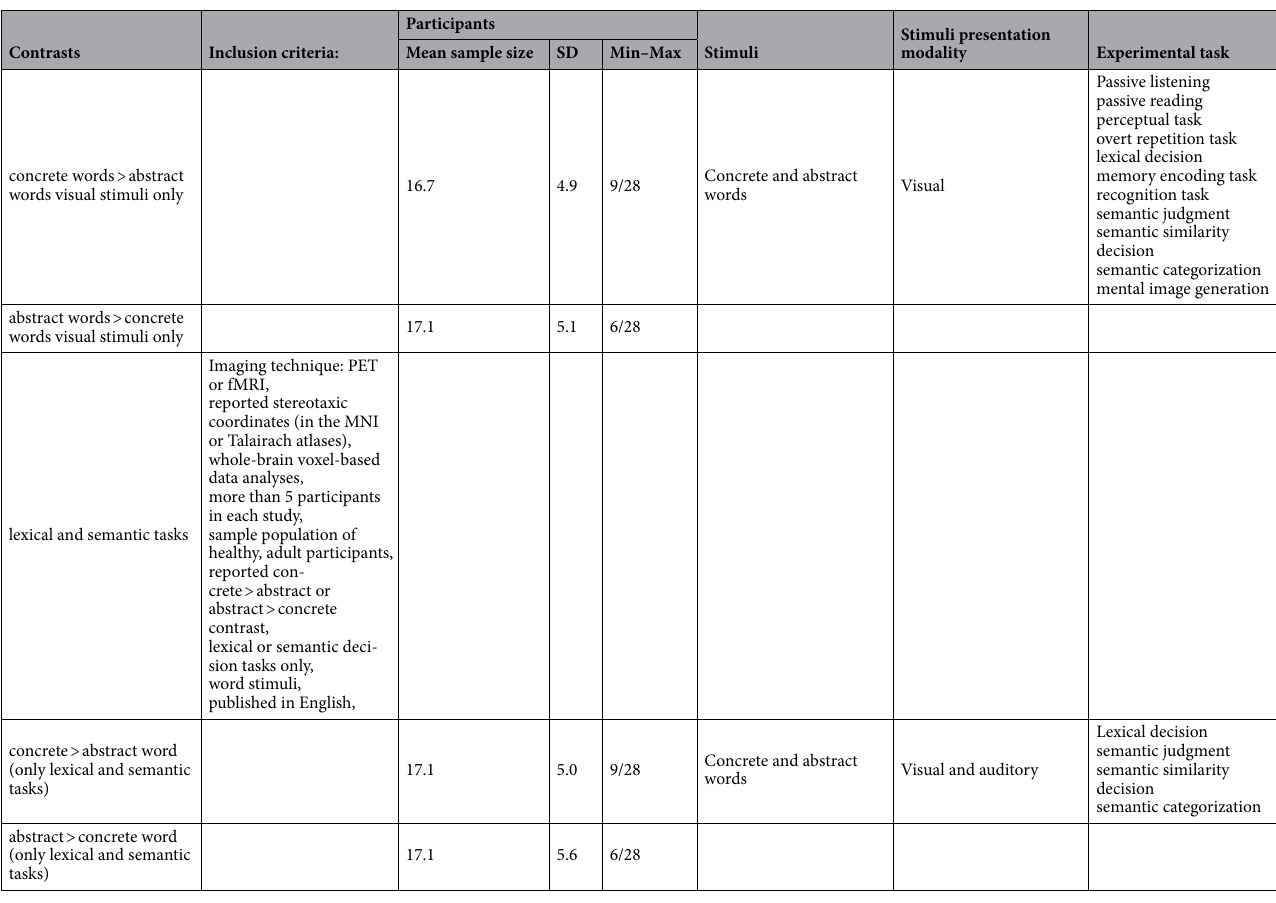
Table 10. Descriptive information for each